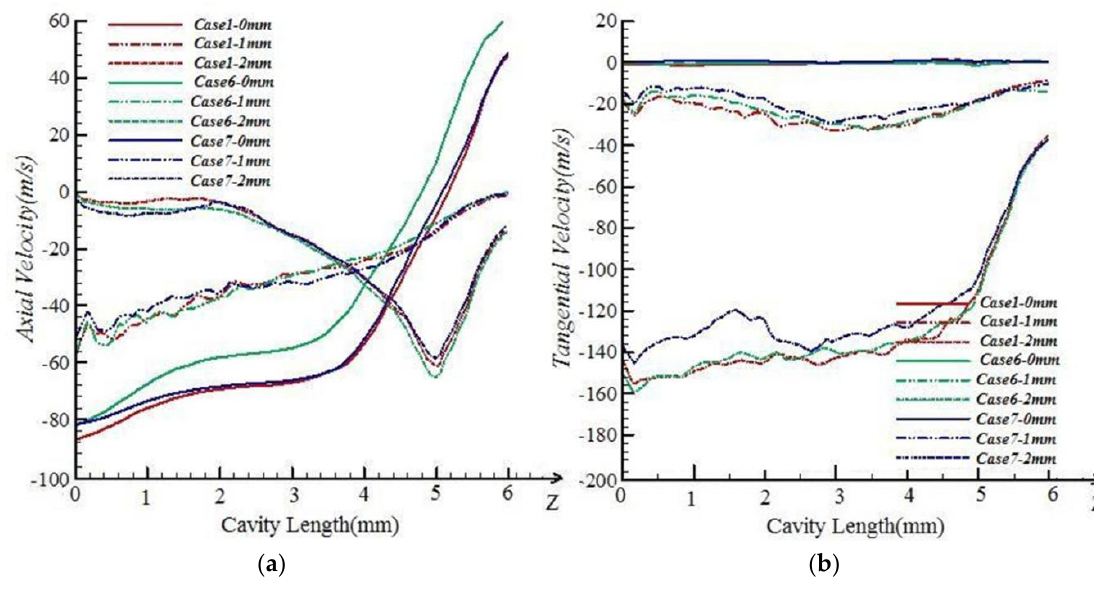
Figure 9. Velocity comparisons among Case1, Case 6, and Case 7. ( a ) Axial velocity; ( b ) tangential velocity.